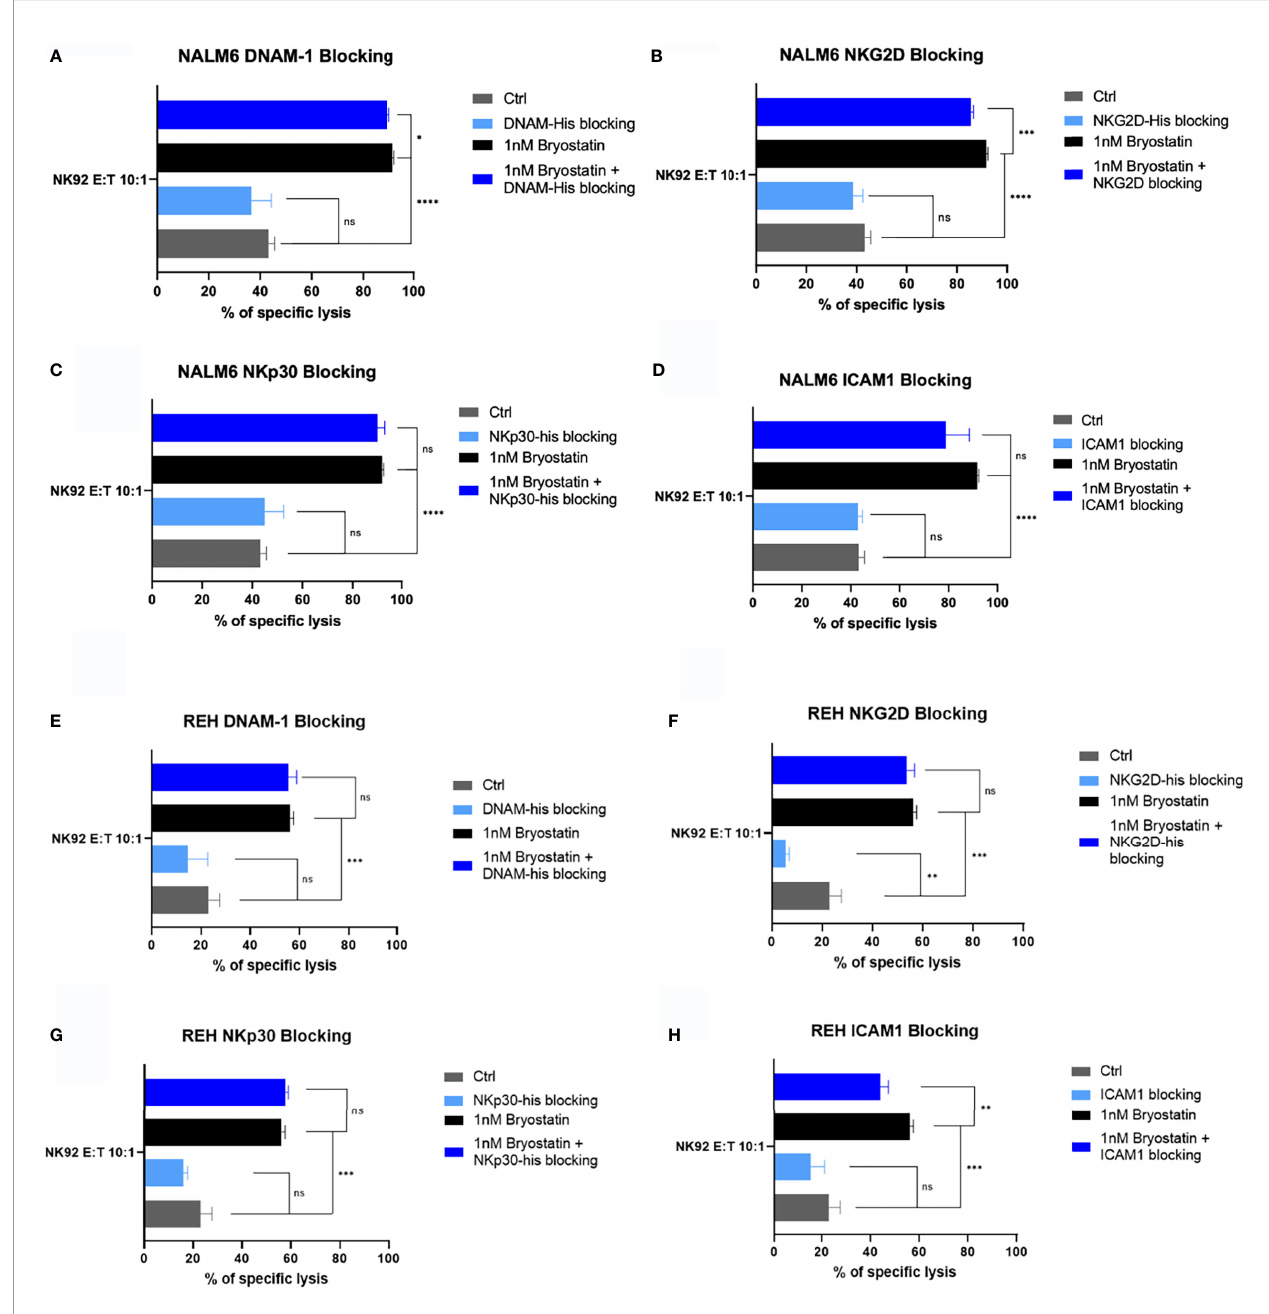
FIGURE 12 | Blocking of innate immunoreceptor ligands during NK92-mediated cytolysis. The NALM6 pre-B ALL cell line, with or without bryostatin-treatment, was cultured with NK92 cells at an E:T ratio of 10:1. Treatment groups are arranged according to the blocking agent tested: (A) DNAM-1, (B) NKG2D, (C) NKp30, or (D) anti-ICAM1 antibody as in Figure 11 . Average of 3 replicate wells are shown, with statistical difference between groups plotted, ns p > 0.05, *p < 0.05, **p < 0.01, ***p < 0.001, ****p < 0.0001. (E – H) REH leukemia cells were similarly